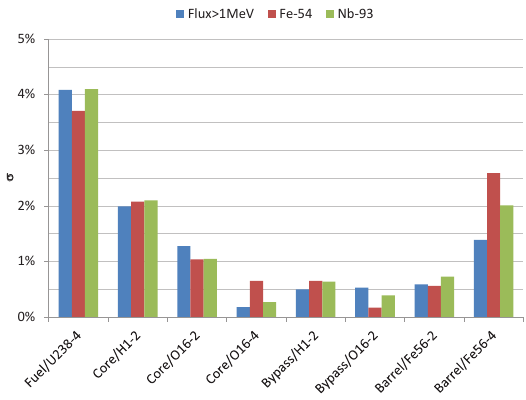
Figure 3. Main uncertainty contributors for the PWR GP dosimetry